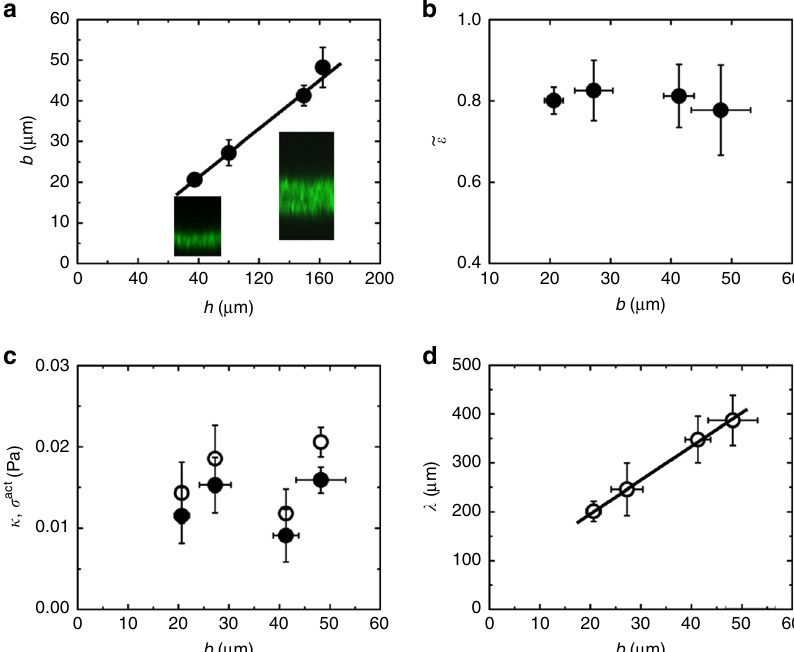
Fig. 7 Effect of fi nal sheet thickness b on the gel mechanical properties and critical buckling wavelength. a Final gel thickness b vs. chamber height h . b Final lateral strain ~ ε relative to the extension of the sheet at t = t max as a function of b . c Gel effective elastic modulus κ (open circles) and active stress σ act at the end of contraction (black dots) as a function of b . d Critical buckling wavelength λ c estimated from scaling ( λ buckling wavelength λ (open circles) as a function of b . Error bars for b and λ indicate standard deviations for N gels gels with N gels = 4 for h = 77 μ m, N gels = 3 for h = 100 μ m, N gels = 3 for h = 150 μ m, and N gels = 3 for h = 160 μ m (Methods). The initial gel radius R and drop volume are: 3.4 mm and 2.8 μ L for h = 77 μ m, 3.7 mm and 4.3 μ L for h = 100 μ m, 3.3 mm and 5.3 μ L for h = 150 μ m, and 3.1 mm and 5.0 μ L for h = 160 μ m. Error bars for κ , ~ ε , and σ act indicate standard deviations for N gels gels with N gels = 3 for h = 77 μ m, N gels = 3 for h = 100 μ m, N gels = 4 for h = 150 μ m, and N gels = 3 for h = 160 μ m (Methods). The initial gel radius R and drop volume are: 1.2 mm and 0.37 μ L for h = 77 μ m, 1.3 mm and 0.53 μ L for h = 100 μ m, 1.3 mm and 0.79 μ L for h = 150 μ m, and 1.5 mm and 1.1 μ L for h = 160 μ m. For the straight line in d , we took ~ ε ¼ 0 : 8 ± 0 : 02 (mean ± SD), which was obtained by averaging the strain measured for all gels in b ( N gels = 13), such that λ c = (7.0 ± 0.1)